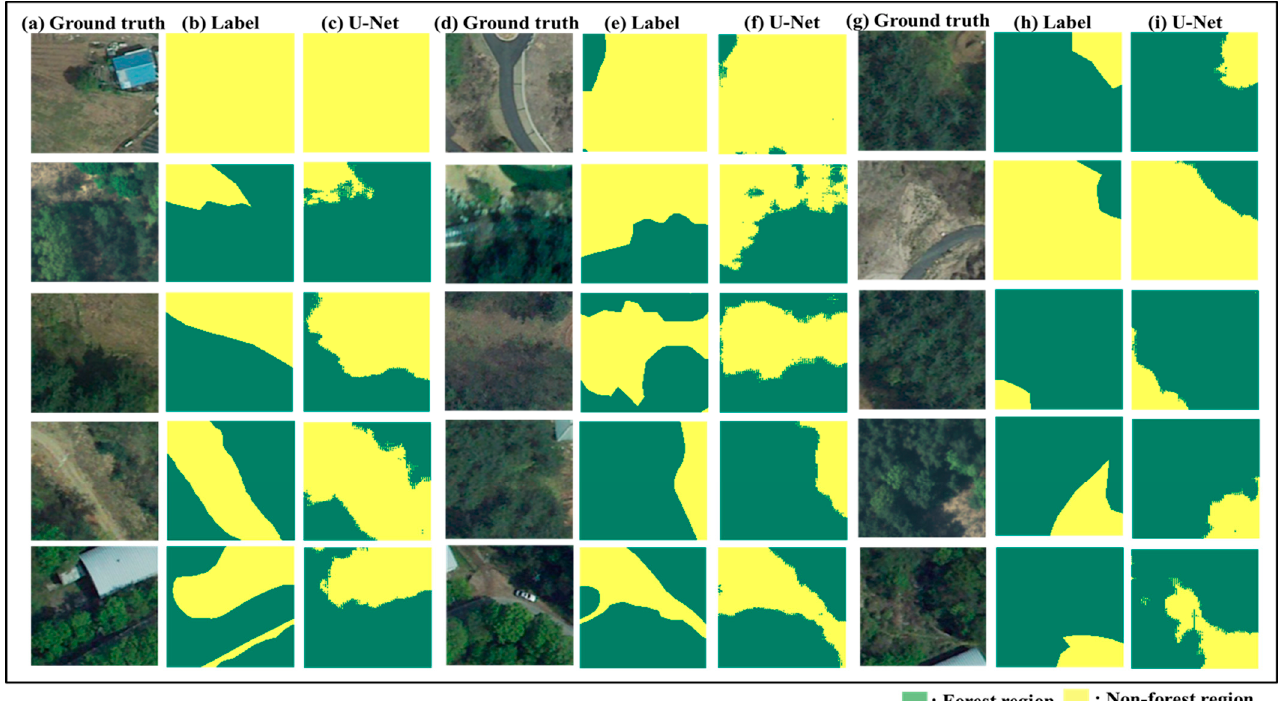
Figure 5. U-Net training results classifying forest and non-forest regions at 1500 epoch. ( a , d ) indicate the RGB images of ground truth in the segmented area, ( b , e ) present label images of forest and non- forest region denoting to 0 and 1, respectively, and ( c , f ) are the forest classification results of U-Net in each image pixel. Green color denotes the forest area while yellow indicates non-forest area.